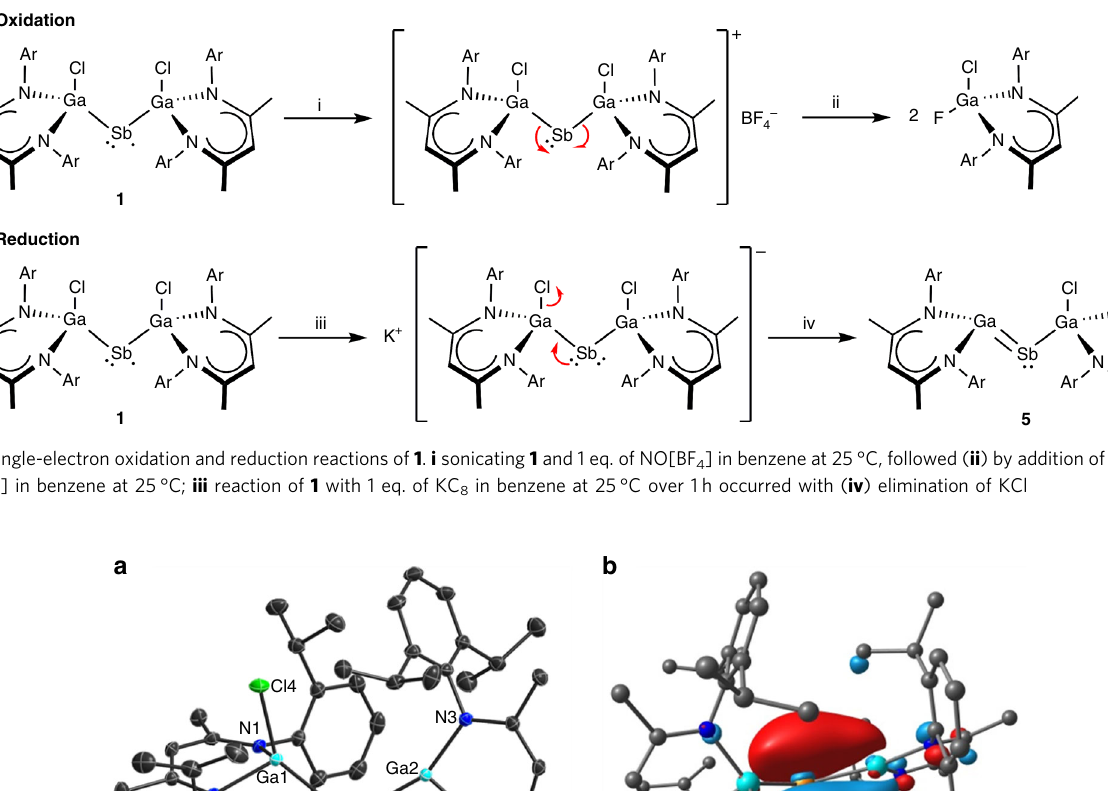
Evans method (solution phase) and by using a SQUID susceptometer ( 4 , solid state) with a fi eld of 1.0 T in the temperature range 2 – 300K. DFT, as implemented in the ab initio quantum chemistry program package ORCA, was employed to calculate molecular geometries, orbital energies and compositions. Additional information to the synthetic, spectroscopic, crystallographic, and computational methods are given in Supplementary Methods. Synthesis of [L(Cl)Ga] 2 Sb · 1 and L(Cl)GaSb(H)Cp* 2 . A mixture of LGa (0.297 g, 0.610 mmol) and Cp*SbCl 2 (0.1 g, 0.305 mmol) in 2 mL of benzene was stirred at room temperature for 7 days. The solvents were removed under reduced pressure and the residue was dissolved in 2mL of hexane. The dark-red solution was kept at room temperature for 3 days to afford dark-red and tiny-yellow crystals. The red crystals were hand-picked under the microscope and fractionally crystallized in 2 mL of hexane. Fractional crystallization was repeated two times to get analytically pure form of 1 . Yield: 181 mg (0.155 mmol, 51%). M.p. 241°C. Anal. Calcd. for C 58 H 82 N 4 Cl 2 Ga 2 Sb: C, 59.67; H, 7.08; N, 4.80. Found: C, 59.55; H, 7.09; N, 4.89%. IR (neat): ν 2957, 2926, 2865, 1521, 1436, 1380, 1313, 1258, 1178, 1098, 1019, 939, 865, 798, 755, 706, 638, 614, 528, 448 cm − 1 . Compound 2 was isolated as colorless crystals (20 mg) while crystallizing the above reaction mixture after stirring at room temperature for 1day in 2mL of toluene at 8 °C. M.p. 135°C (dec.). Anal. Calcd. for C 39 H 57 N 2 ClGaSb: C, 59.99; H, 7.36; N, 3.59. Found: C, 60.20; H, 7.54; N, 3.54%. IR (neat): ν 2966, 2919, 2866, 1855, 1552, 1522, 1441, 1382, 1312, 1248, 1184, 1102, 1020, 933, 862, 798, 763, 635,